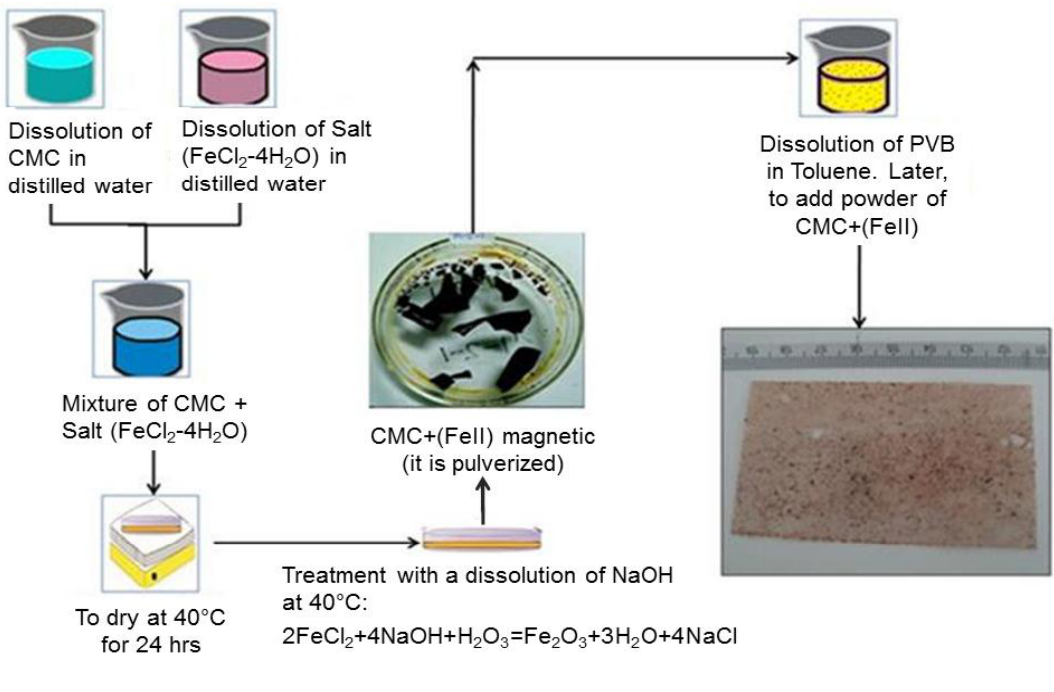
Figure 2. Process to obtain the (Fe 2 O 3 -CMC)/PVB magnetic hybrid polymer.